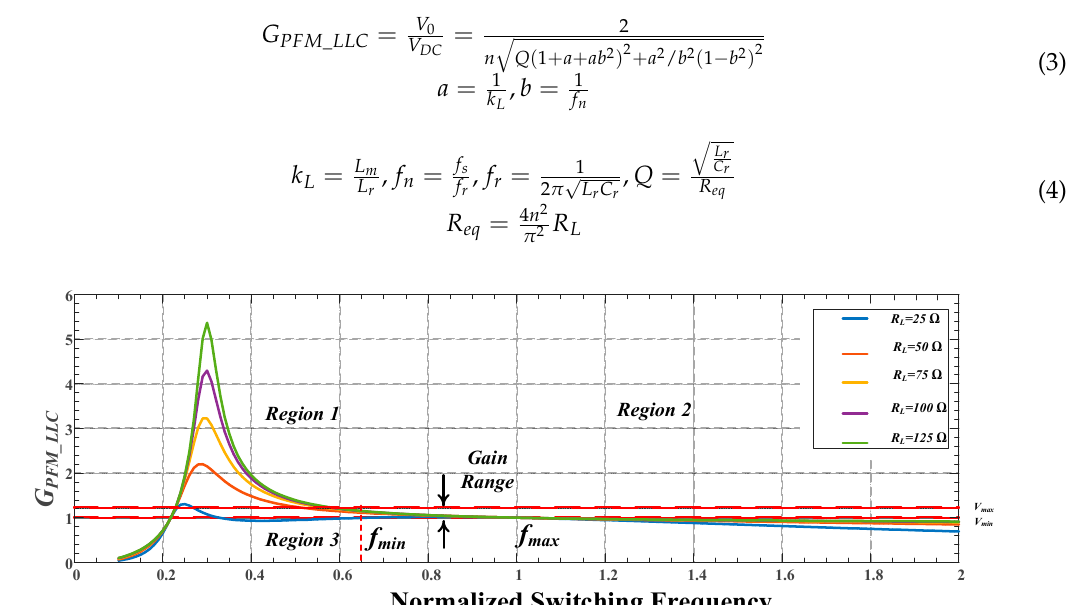
Figure 6. Gain curves of the proposed converter under pulse frequency modulation (PFM) in FM.